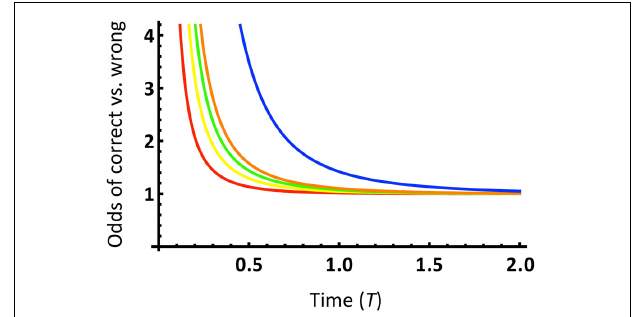
FIGURE 6 | Ratio of the probability of support for the correct topology to the probability of support for either incorrect topology over time T , for a site with a substitution rate λ = 1 and an internode length t 0 = 0 . 1, from Equations 4 and 5 in Townsend et al. (2012). The probability ratio curves are depicted for state spaces of 2, 3, 4, 5, and 20 states, respectively, from bottom to